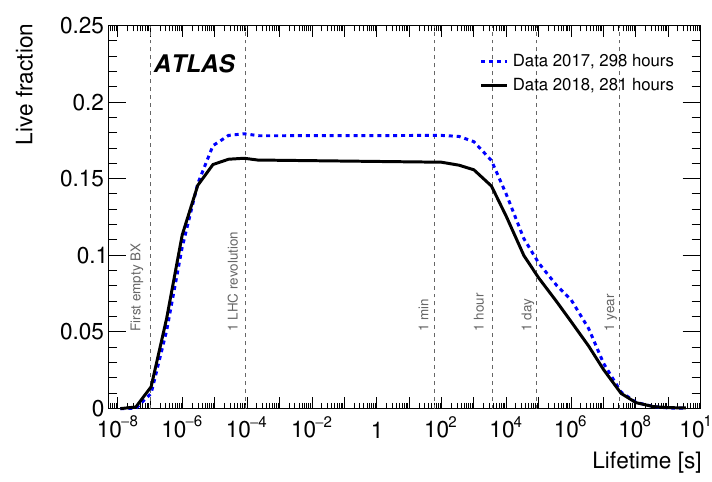
Figure 2 . The live fraction for empty-BX data considered in this analysis as a function of particle mean proper lifetime for data collected during 2017 and 2018. For small lifetimes, per-BCID luminosities and the LHC bunch structure are used to calculate the live fraction until it flattens at ∼ 100 µ s, where the live-time is dominated by the trigger live fraction and the bunch structure. At large lifetimes, the run schedule throughout the year dominates the